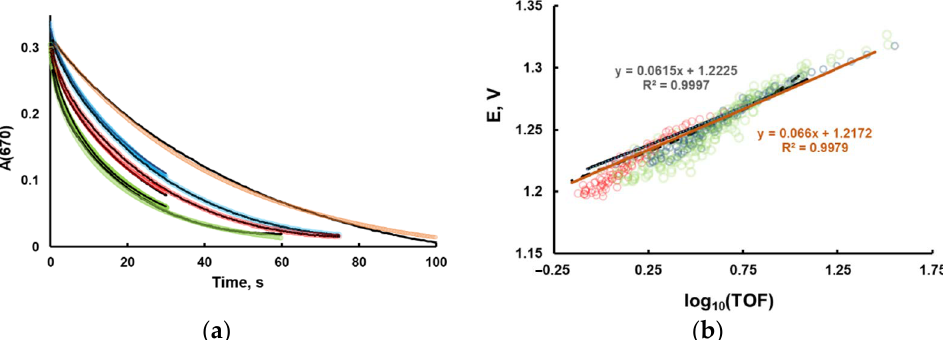
Figure 3. ( a ) The kinetics of [Ru(bpy) 3 ] 3+ consumption measured at 670 nm. Sodium borate buffer (25 mM) at pH 8.0, 0.85 mM [Ru(bpy) 3 ] 3+ , Ru 4 POM —0 (orange), 2.5 (blue), 5.0 (red), and 10 μ M (green). The fitting using Copasi software to the mechanism in Equations (15)–(21) is in solid lines [20]; ( b ) turnover frequency (TOF) and potential are calculated as described in the text. The brown line is calculated using Equation (15). The black line is generated by Copasi software with the same parameters as in ( a ).